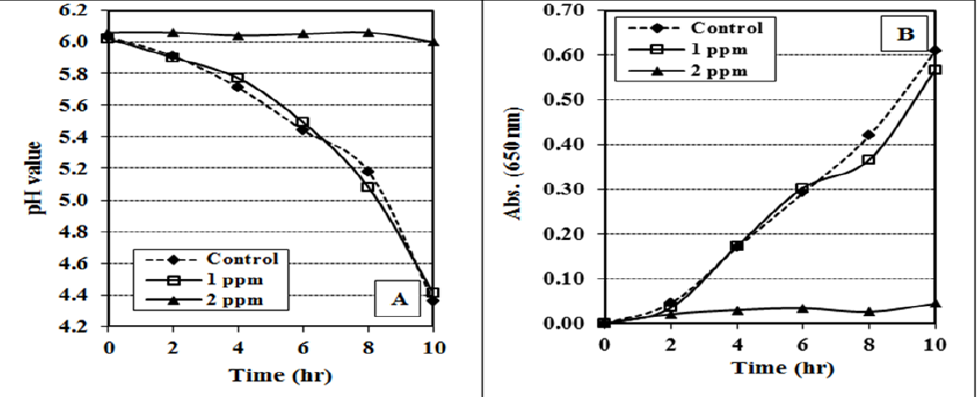
Figure 2. Effect of potassium chromate (K2CrO4) on the pH ( A ) and absorbance ( B ) progress of MRS broth media inoculated with yoghurt culture and incubated at 40 °C for 10 h. The data are shown as mean ± SE for three replicates.